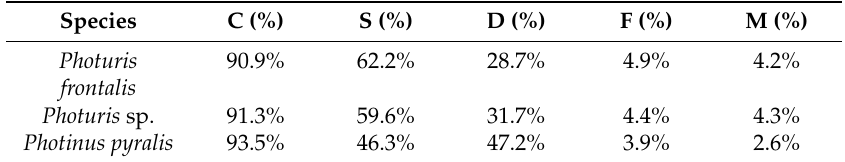
Table 2. Benchmarking Universal Single-Copy Orthologs (BUSCO) assembly scores. C = Complete BUSCOs. S = Complete and single-copy BUSCOs. D = Complete and duplicated BUSCOs. F = Fragmented BUSCOs. M = Missing